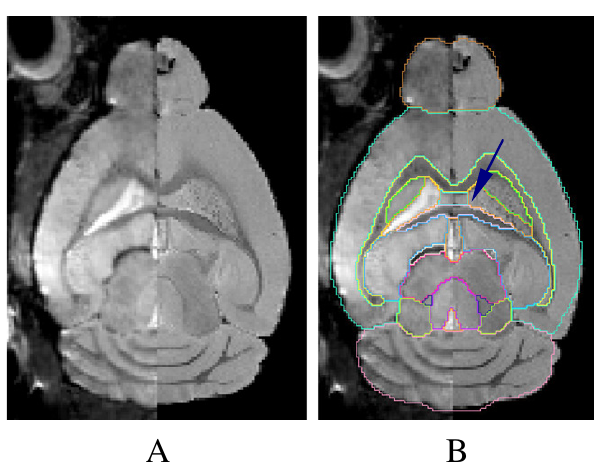
Figure 6. (A) The side-by-side difference of an in vivo (left half of the image) and an in vitro brain (right half of the image). (B) The in vivo atlas superim- posed on (A) . The ventricles are barely visible in the in vivo image (left half of the image) (as pointed out by the arrow and outlined by the in vivo atlas).